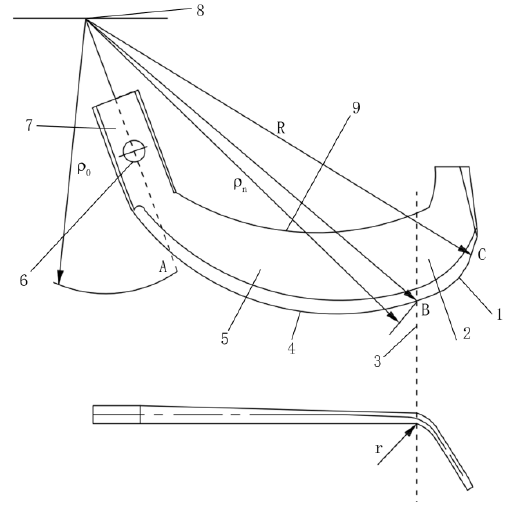
Figure 1. Schematic diagram of rotary blade structure. 1. positive cutting edge; 2. front cutting part; 3. bending line; 4. side cutting edge; 5. side cutting part; 6. mounting hole; 7. tool handle; 8. rotary center of knife roller; 9. curve of back edge.